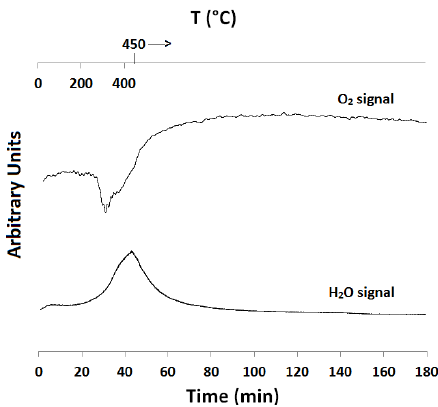
Figure 3. H 2 O release during initial oxidation of the 0La catalyst and O 2 consumption during the